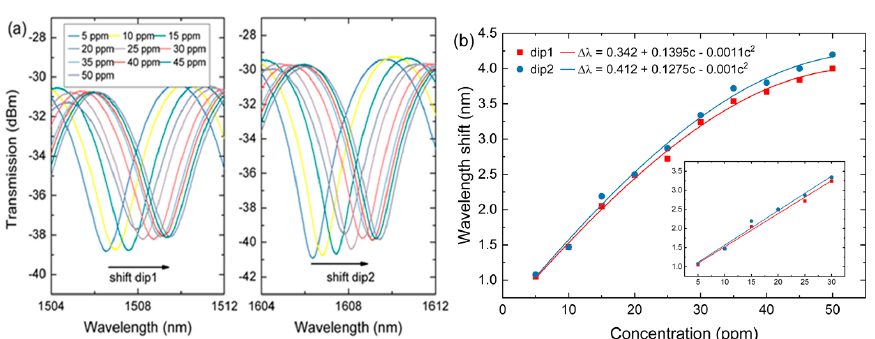
Figure 5. ( a ) Transmission spectra of MFI with different ammonia nitrogen concentration for dip1and dip2. ( b ) The linear relation between dip position and concentration for dip1 and dip2, the inset is the linear fit for low concentrations of 5–30 ppm.